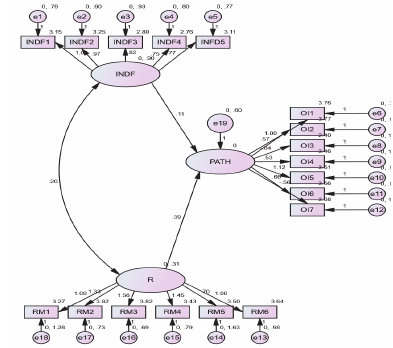
Fig. 3. Measurement model Fig. 4. Structural model between research mobilisa- tion, individual factors and pathway for entrepreneurs